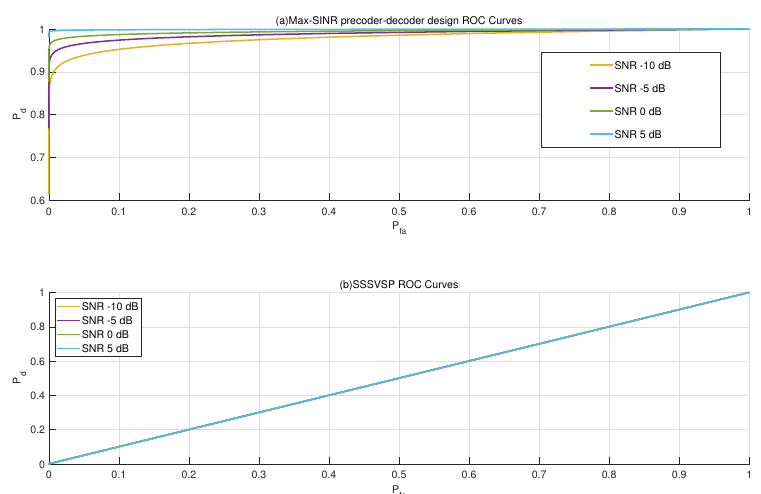
Figure 4. The radar’s ROC curve comparison between the proposed max-SINR joint precoder– decoder design ( a ) and SSSVSP ( b ) in − 10, − 5, 0 and 5 dB